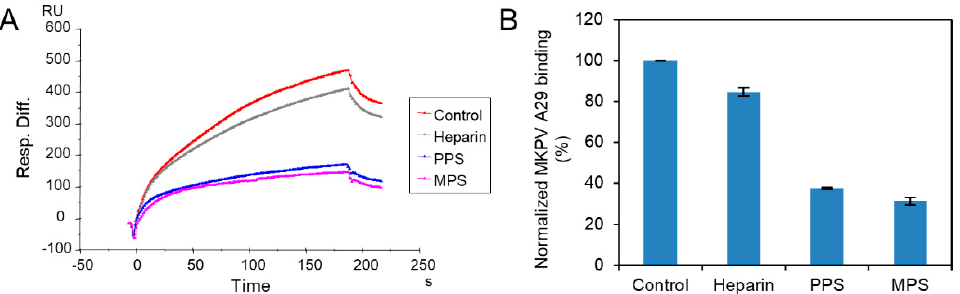
Figure 5. Solution competition between heparin and sulfated glycans. ( A ) SPR sensorgrams of MPXV A29–heparin interaction, by competing with PPS or MPS. Concentration of MPXV A29 is 250 nM mixed with 1000 nM of sulfated glycans. ( B ) Bar graphs (based on triplicate experiments with standard deviation) of normalized MPXV A29 binding preference to surface heparin, by competing with PPS or MPS.